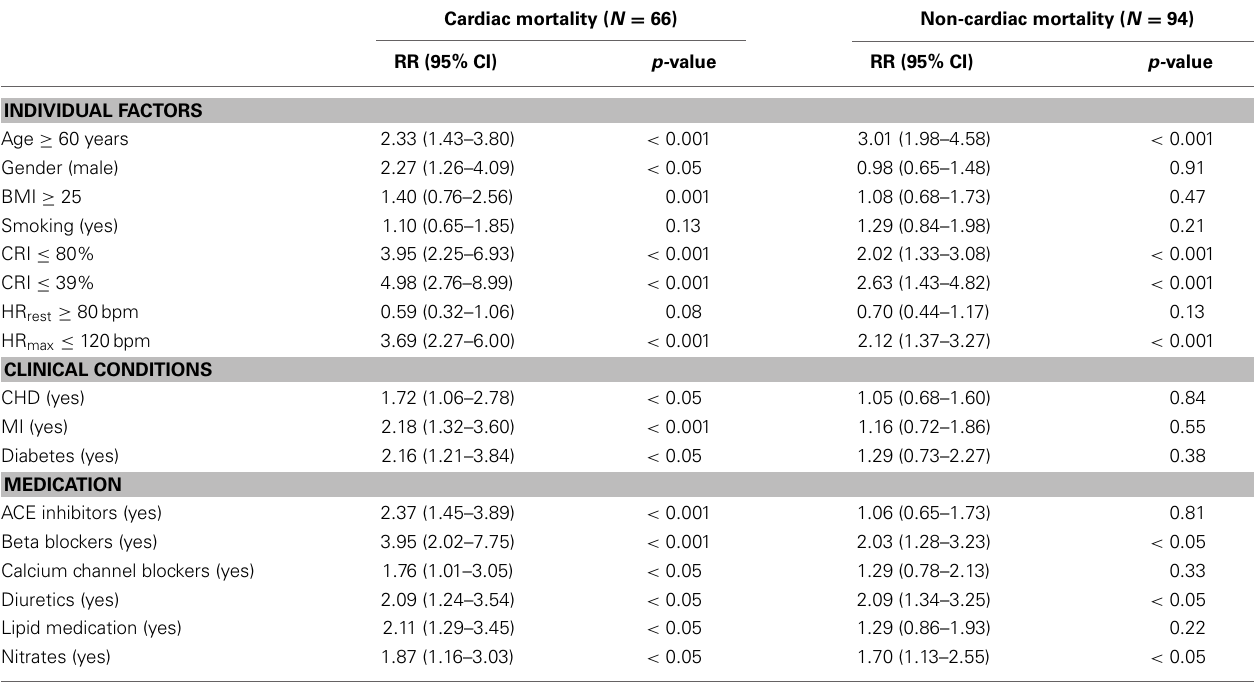
Table 2 | Association of individual factors, clinical conditions and medication to cardiac and non-cardiac mortality based on univariate Cox